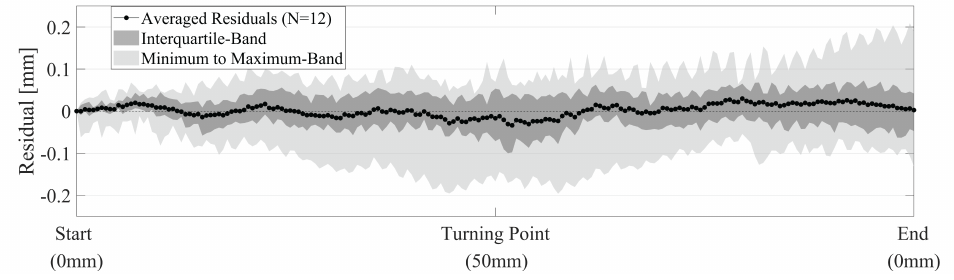
Figure 14. Statistical distribution for experiments carried out in the outdoor environment. Residuals quantify discrepancies between positions measured with the TIDEP-01012 and translation stage positions. The full translation stage motion from 0 to 50mm took approximately 5